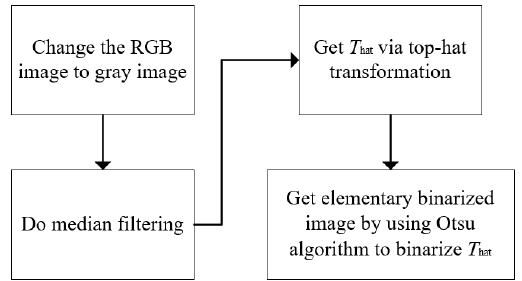
Figure 3. Flowchart of pre ‐ processing.